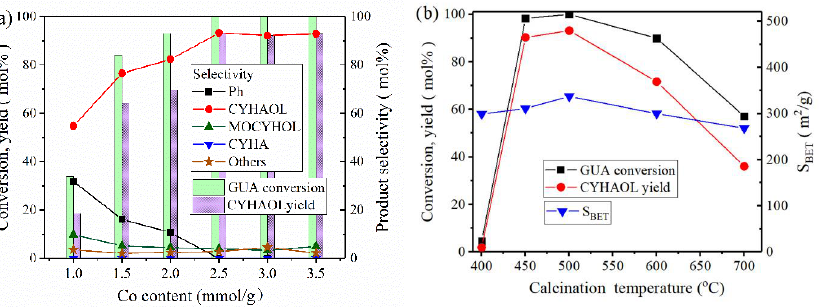
Figure 6. Influence of catalyst preparation conditions on HDO of GUA reactions: ( a ) Co loading amounts; ( b ) catalyst calcination temperature (reaction conditions: 300 mg of GUA in 10 mL of n-dodecane; catalyst loading = 30 mg; 200 °C; 1 MPa H 2 ; 2 h).